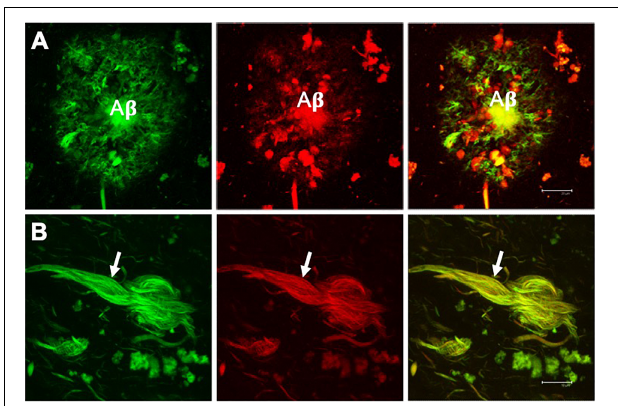
FIGURE 2 | Double fluorescent staining of a case with Alzheimer’s disease. Amyloid plaque (A) and neurofibrillary tangle (NFT) (B) evidenced by the dye thioflavin S (TS, green channel ) and thiazine red (TR, red channel ). Both markers co-locate, giving a yellow color in the merged channel. TS and TR demonstrate the fibrillar state with the β -folded conformation of the amyloid β -peptide (A β ) and the tau protein assembled into filaments. Scale bar (A)